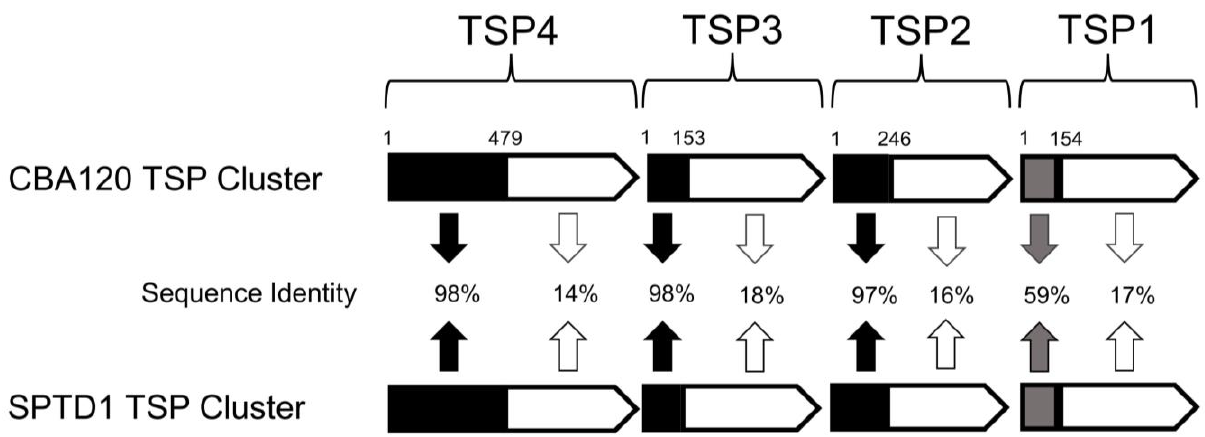
Figure 1. The genome of SPTD1 encodes for a TSP Cluster (ORF316, 318, 319, and 321) with significant N-terminal homology to the TSP Cluster of CBA120 (ORF 210 – 213). Comparisons of N- and C- terminal regions for each TSP were performed using EMBOSS Needle [36,37]. Protein amino acid sequence identity between CBA120 and SPTD1 for each TSP section is indicated, as are the boundaries of comparison. N-terminal regions of high (greater than 95%) and moderate (greater than 50%) sequence identity are indicated in black and grey, respectively. C-terminal regions with limited sequence identity (less than 20%) are indicated in white.